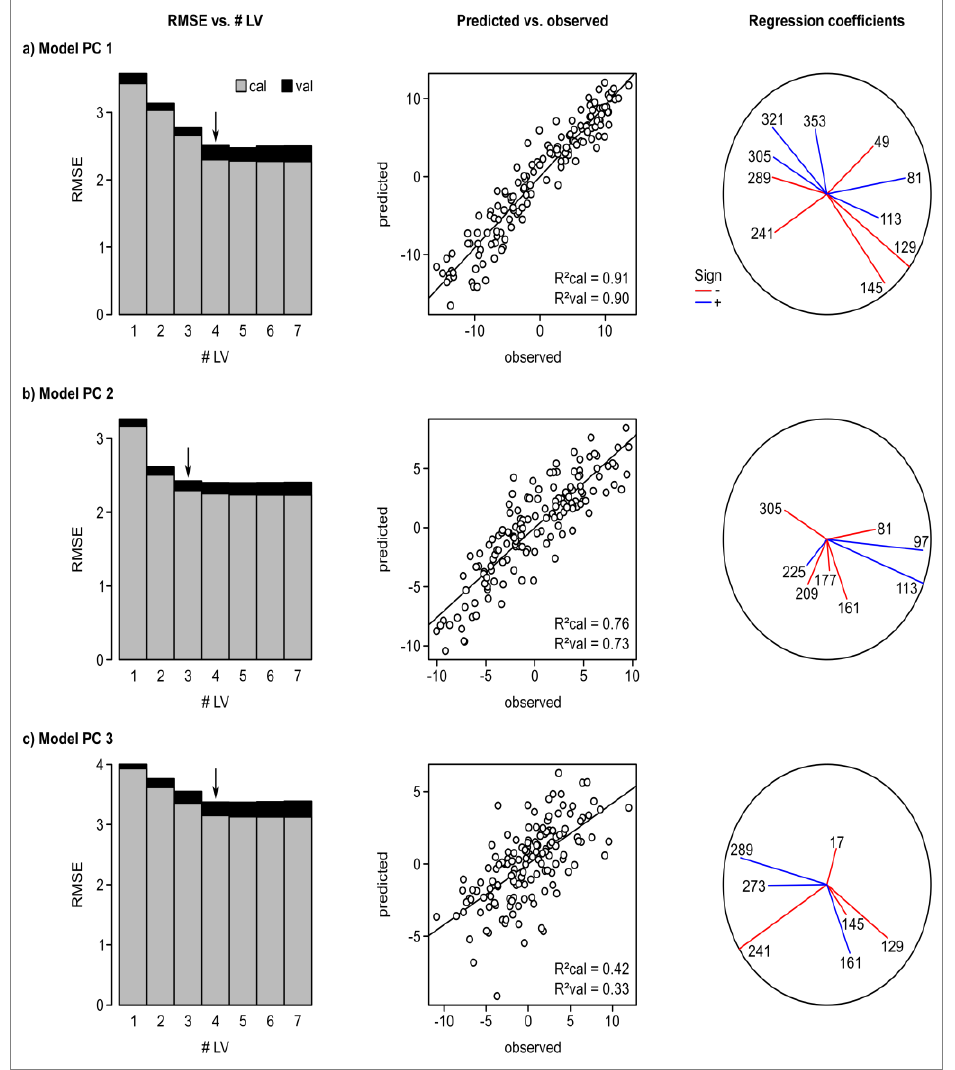
Figure 7. Spatial autocorrelation (Moran’s i) in the residuals of PLSR-models at different centroid distances between